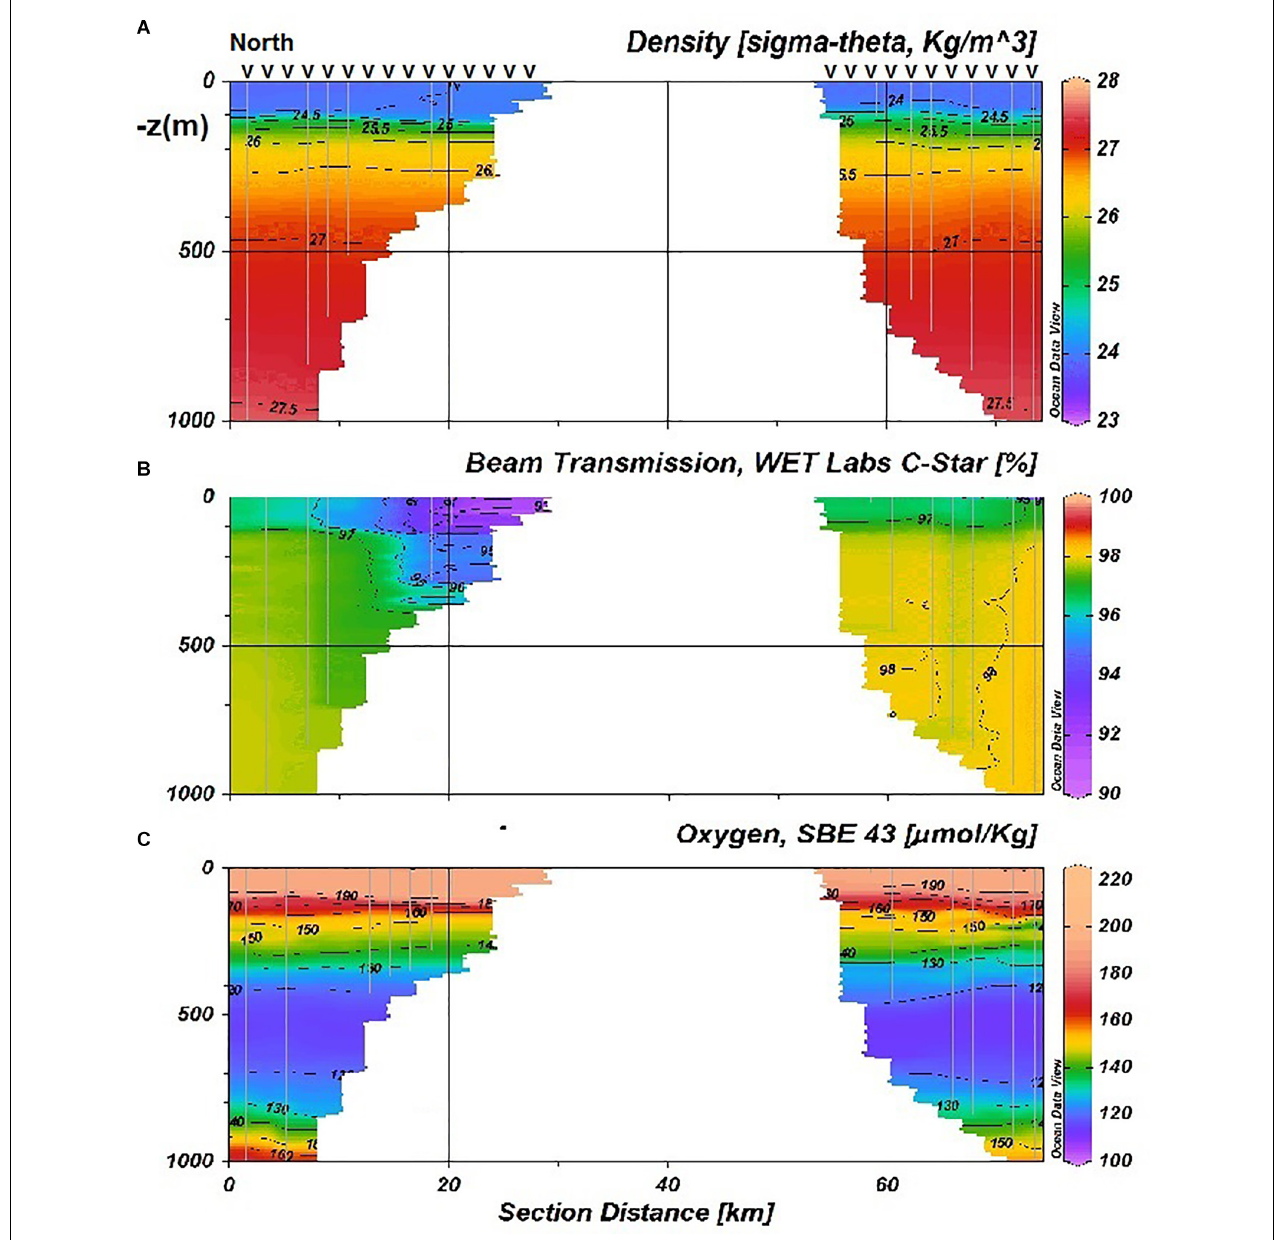
FIGURE 2 | Cross section of the water column along CTD-transects to the north and south of Saba Bank. North is to the left. The tick-marks indicate the stations. (A) Density anomaly referenced to the surface. (B) Beam transmission. (C) Oxygen